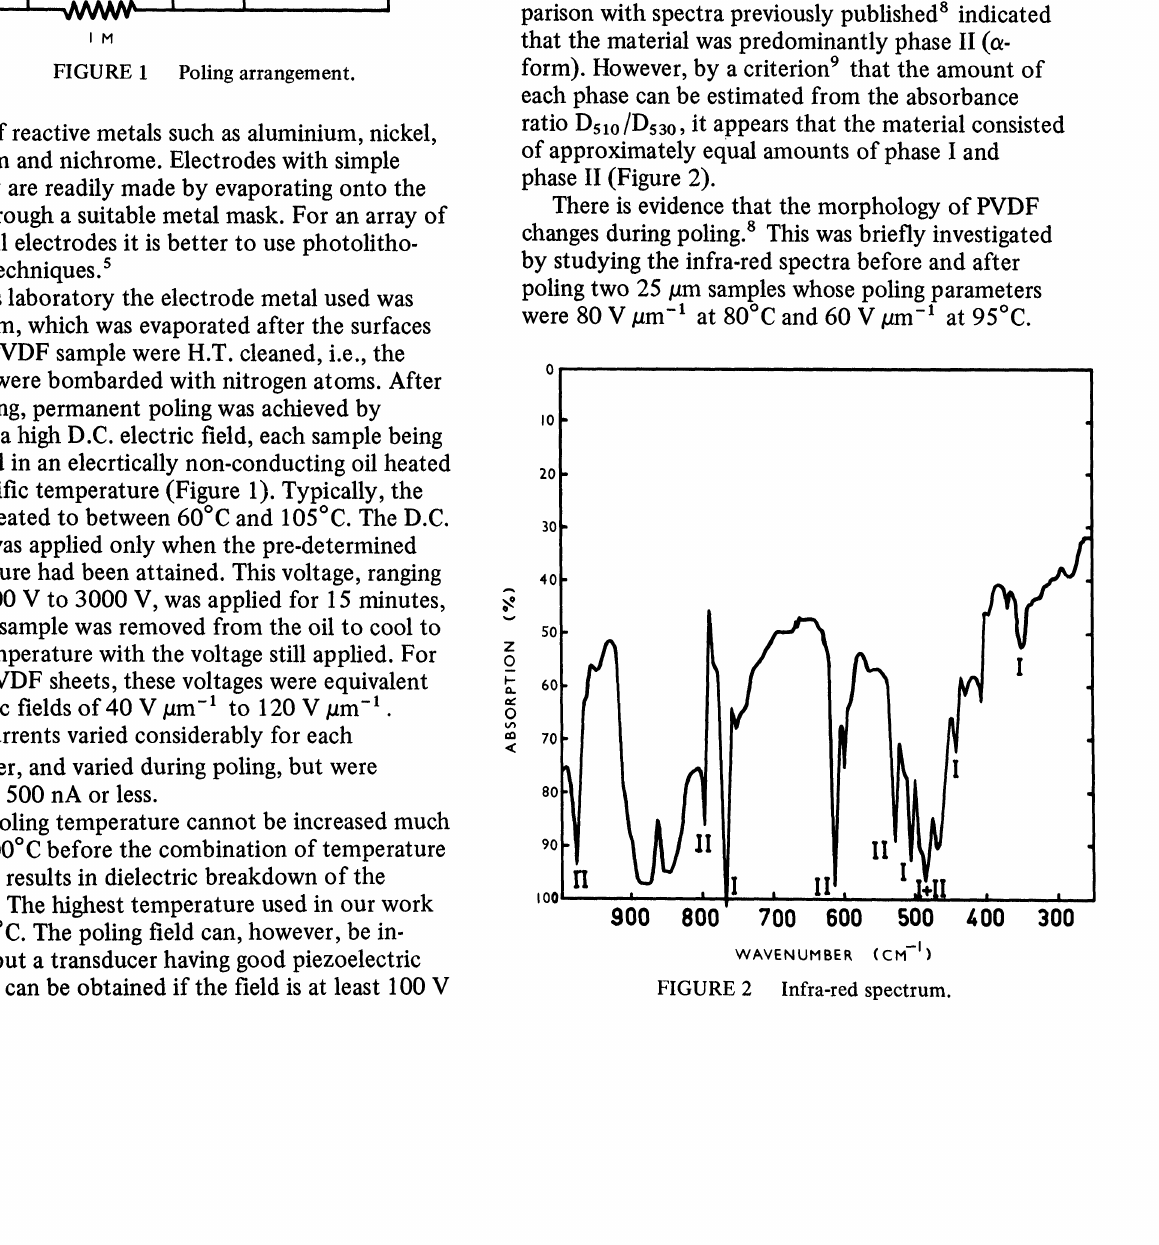
FIGURE 1 Poling